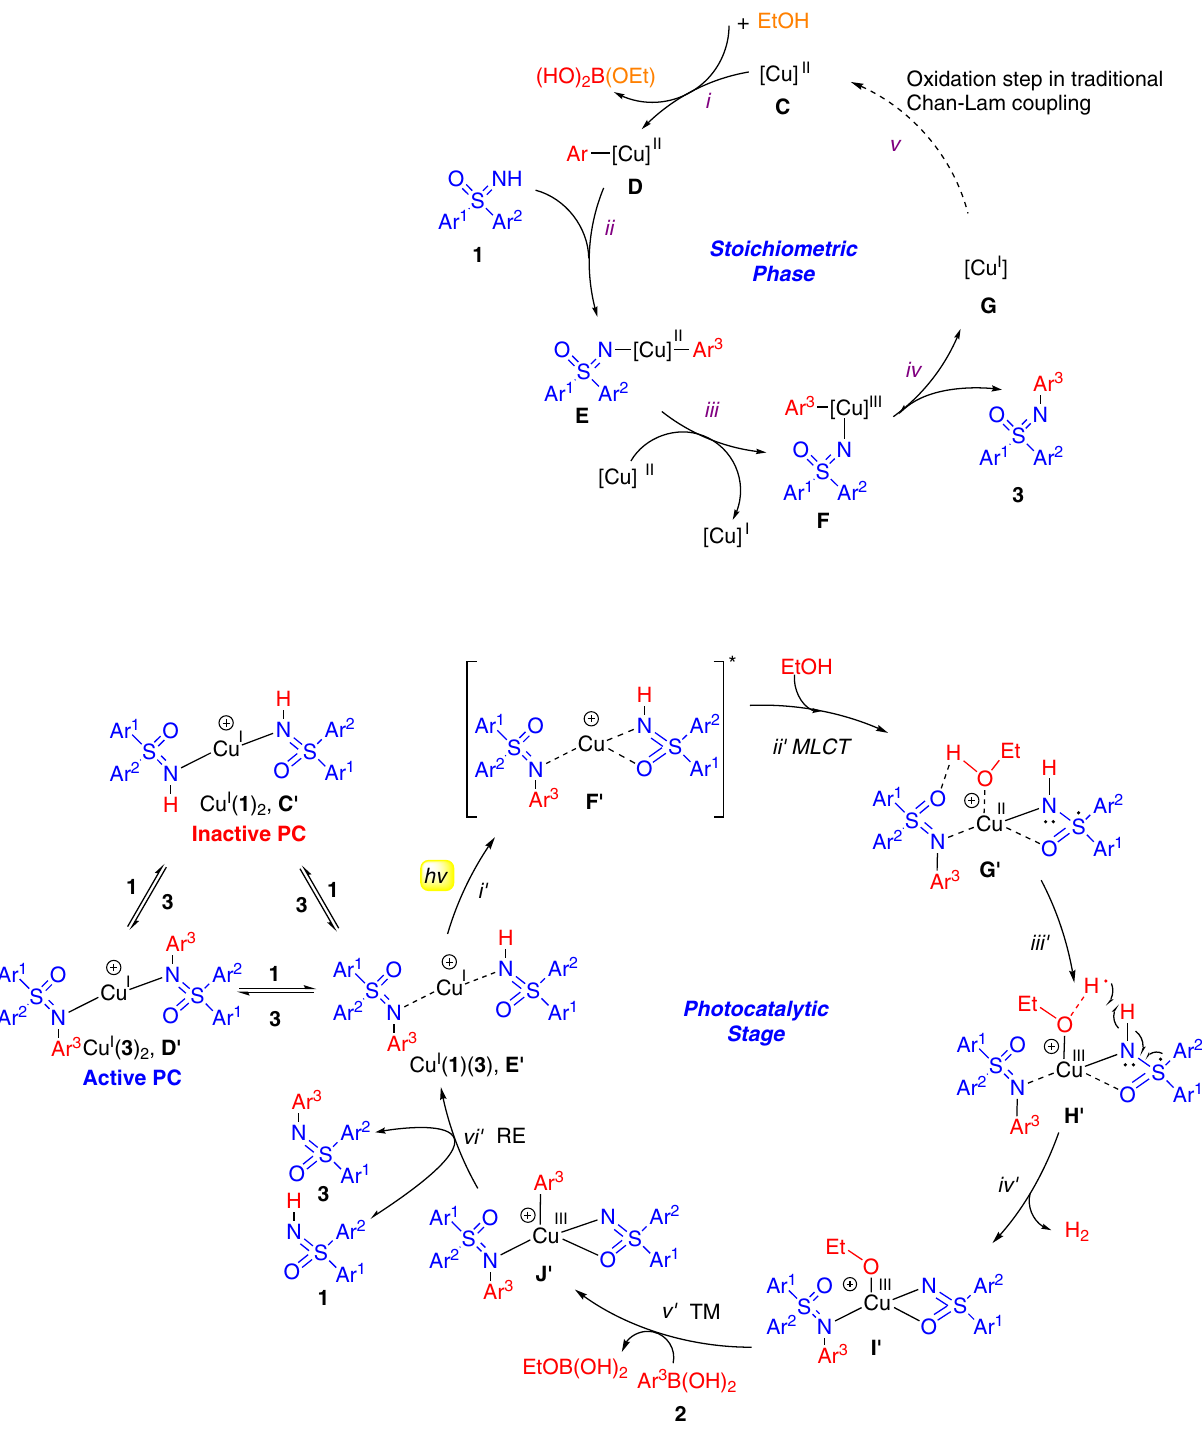
Fig. 5 Proposed mechanism of copper-catalyzed photoredox Chan-Lam coupling. The reaction was initiated by a stoichiometric classical oxidative Chan- Lam coupling, and then entered the photocatalytic stage after N -arylted product 3 and NH -sulfoximine 1 binding to Cu(I) together to form the active photocatalyst E ’